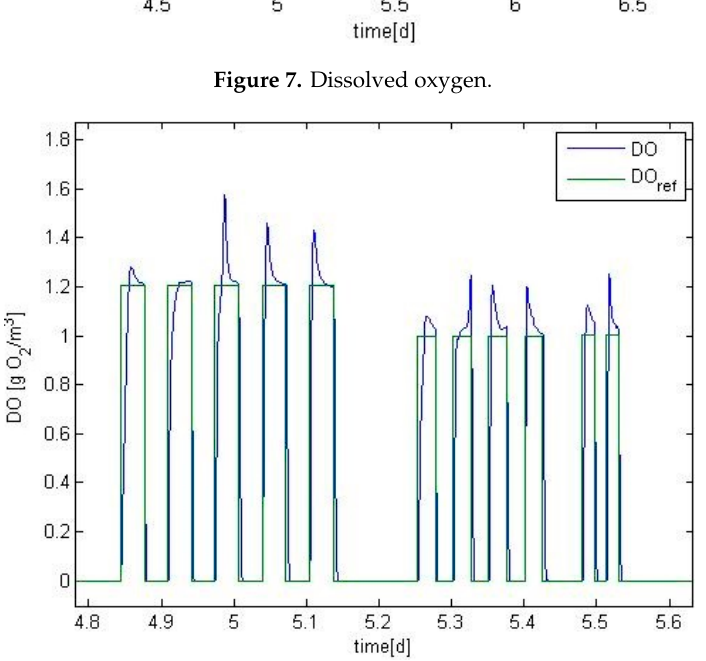
Figure 7. Dissolved oxygen.